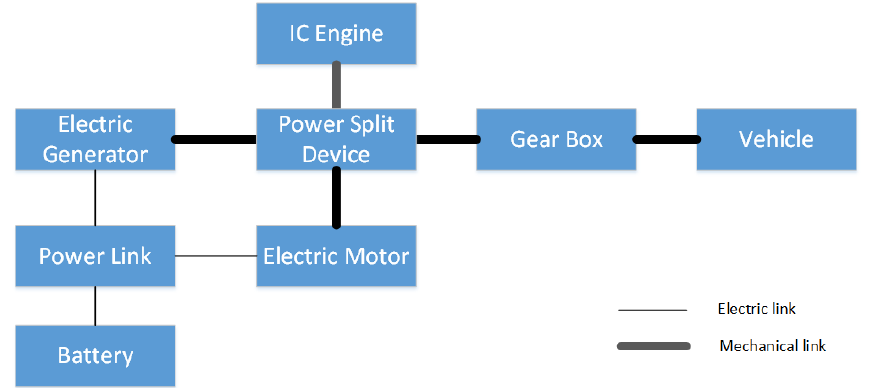
Figure 6. Combined hybrid